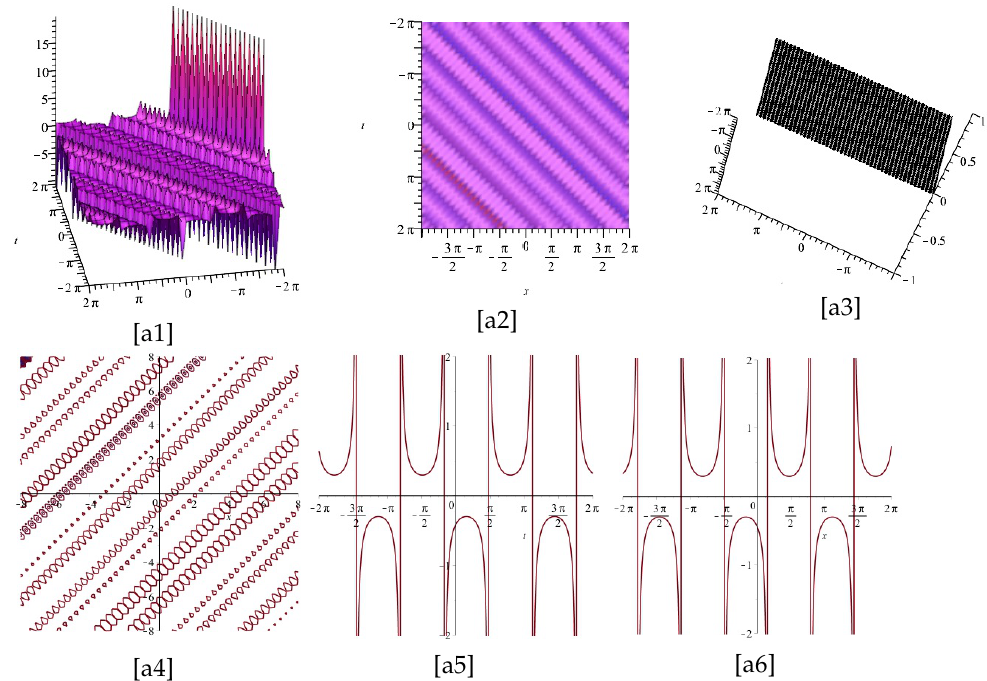
Figure 1. The plots of Equation (30), for λη > 0 and α = 1. Now, [a1] and [a3] are imaginary and real parts of Equation (30), and [a2], [a4], [a5], and [a6] display the z -axis orientation, the contour plot, the 2d for x = 2, and the 2d for t = 2, of the imaginary part of [a1], respectively.